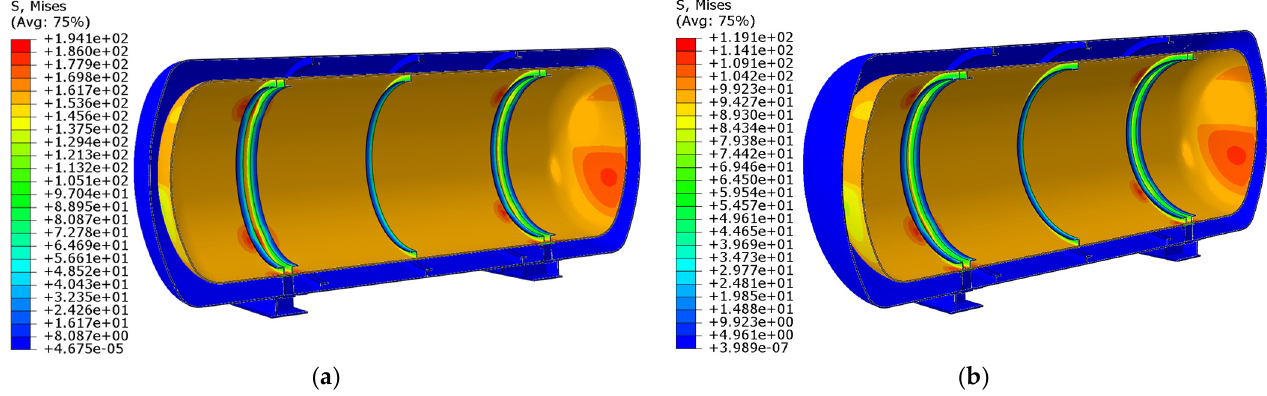
Figure 10. Thermal stress distribution of LNG fuel tank: ( a ) SUS304; ( b ) AL-5083-O.